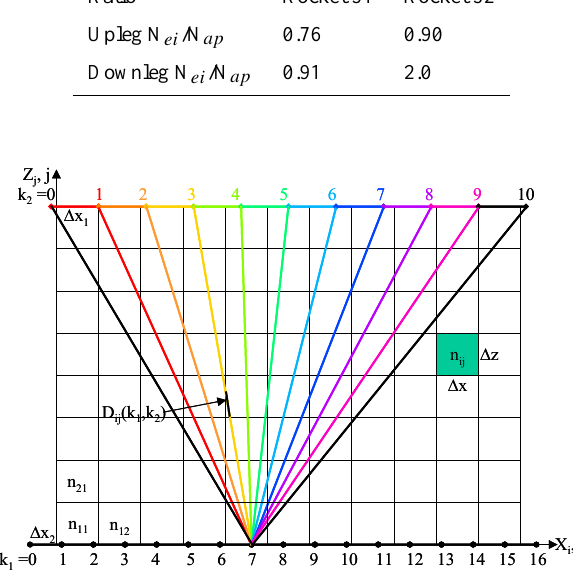
Figure 9. Matrix of cells used to derive electron densities from a radio beacon TEC. Fig. 9. Matrix of cells used to derive electron densities from a radio beacon